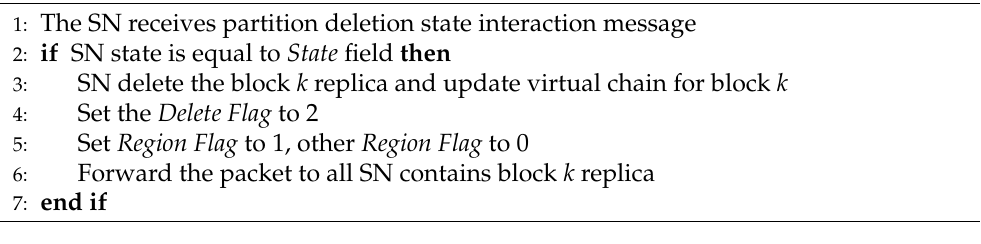
Algorithm 3 Block replica deletion and update.